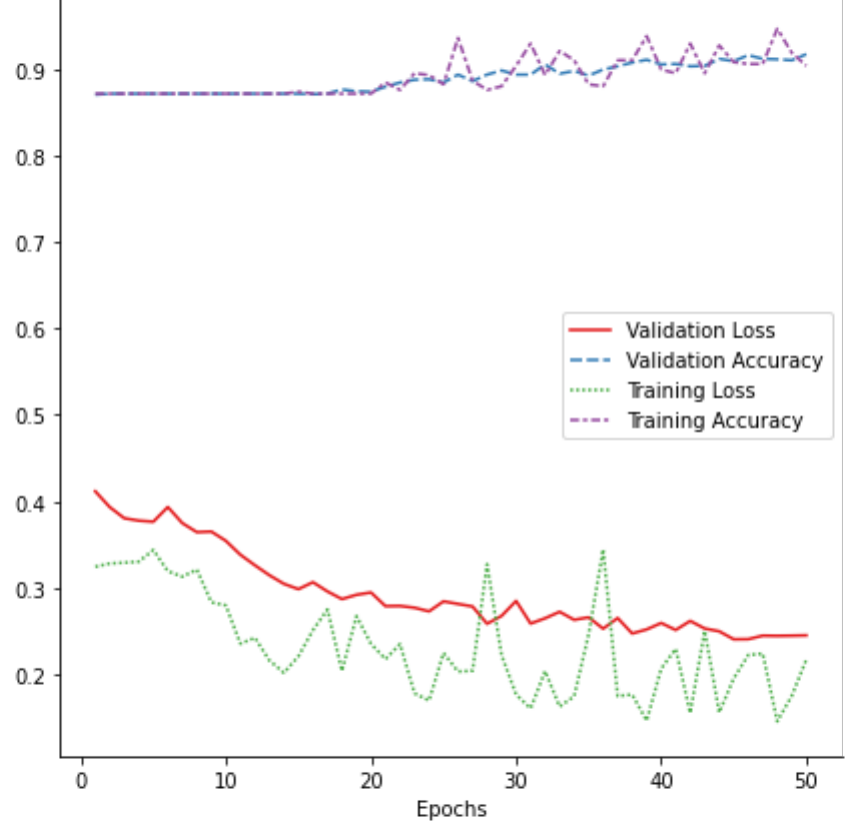
Figure 10. Learning History of Case Model.